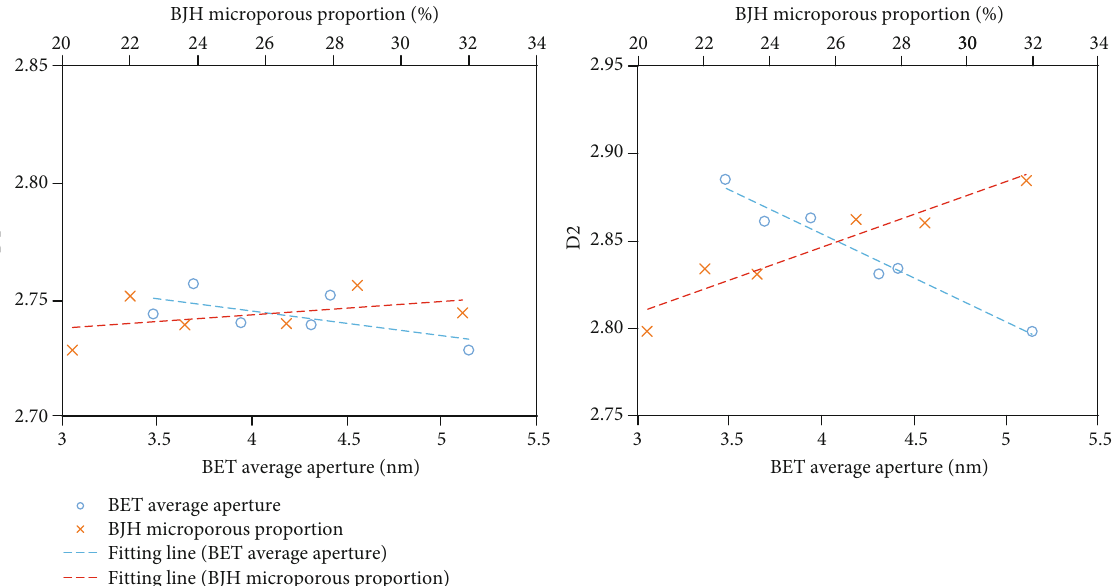
Figure 9: Relationship between fractal dimension and pore size.